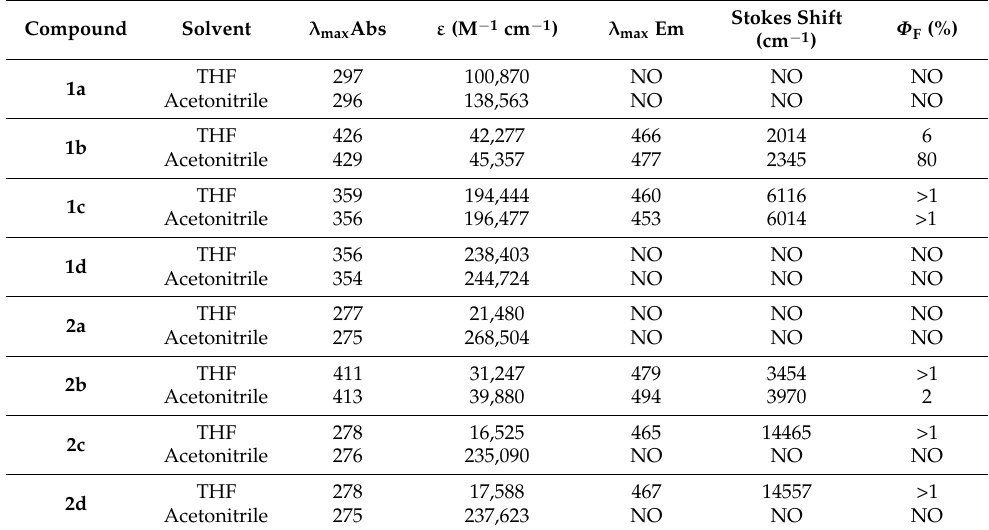
Table 2. Experimental photophysical properties in a solution of compounds 1a – d and 2a – d